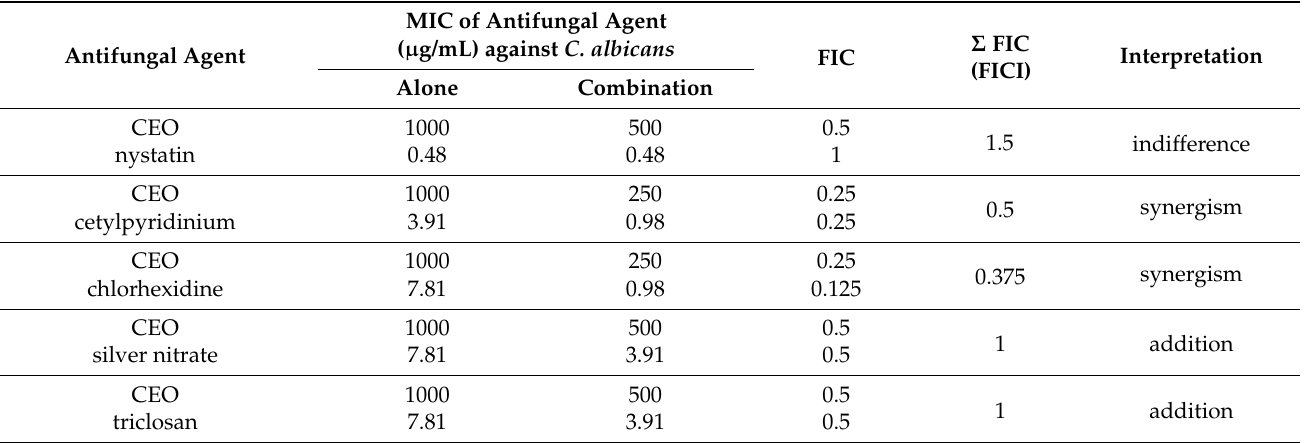
Table 5. MICs and FIC indices of CEO alone and in combination with selected antimycotics on reference C . albicans ATCC 10231 strain.